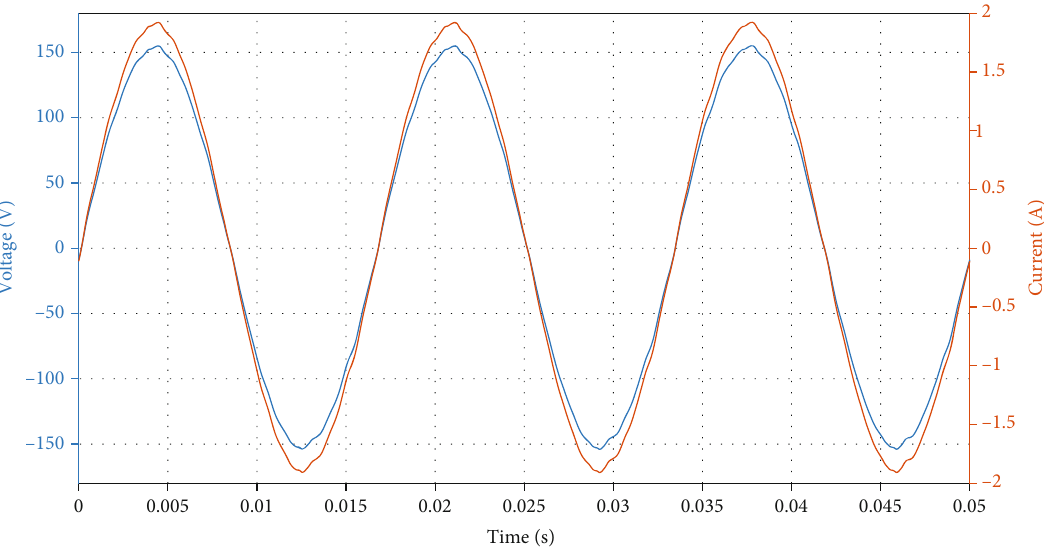
Figure 7: Output voltage and current waveform with LC fi